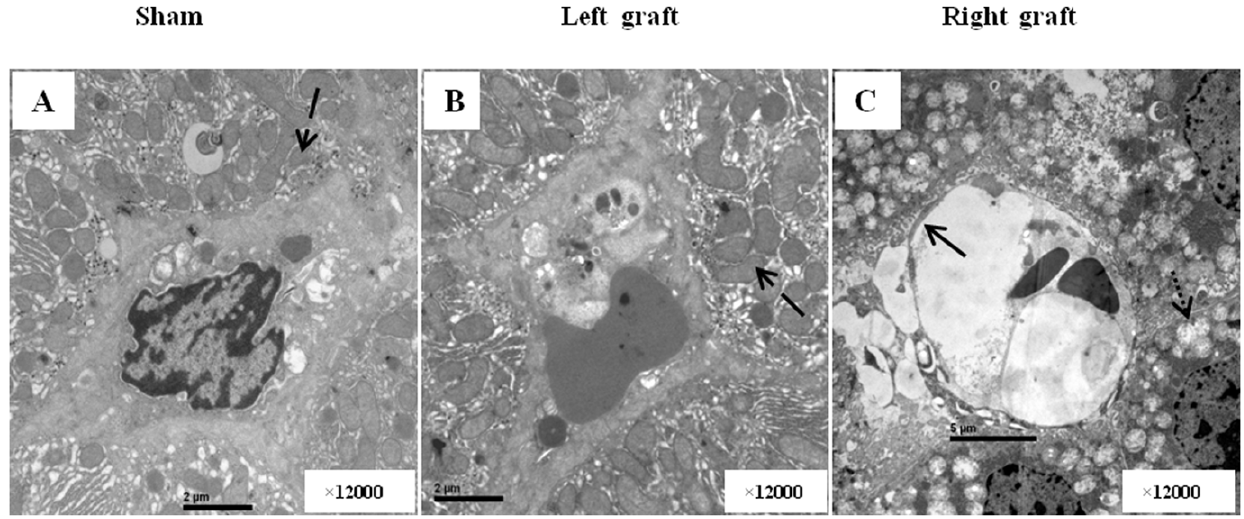
Figure 3. Electron microscopy results 1 day after reperfusion. A, In sham group, hepatocyte and sinusoidal cell had normal appearance. B, In right graft, The continuity of the endothelium was preserved except for minimal edema and defenestration. the liver architecture was maintained without obvious features of cellular destruction. C In left graft, integrity of endothelial cells was disrupted. Sinusoidal congestion and irregular large gap in the sinusoid lining cells were found. Mitochondrial swelling and vacuolar changes in cytoplasm of hepatocytes were obvious. The normal arrow indicated the endothelium, the dot arrow indicated mitochondrial vascuolar changes.